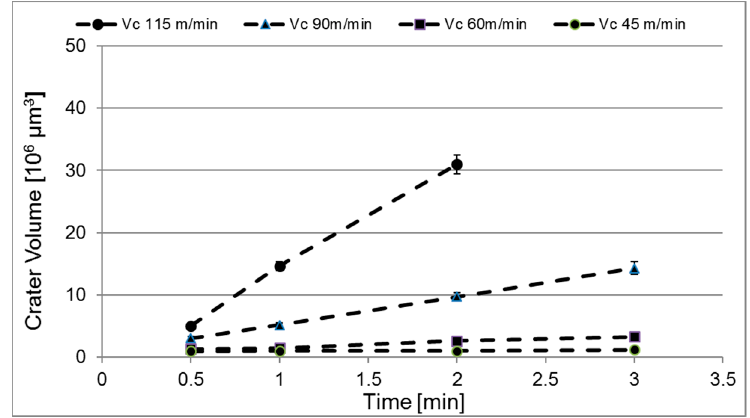
Figure 6. Crater wear vs time at a feed rate of f n = 0.15 mm / rev and a cutting speed of v c = 45, 60, 90 and 115 m / min. Above 2 min the combination f n = 0.15 mm / rev and v c = 115 m / min results in extensive plastic deformation and macroscopic cracking.